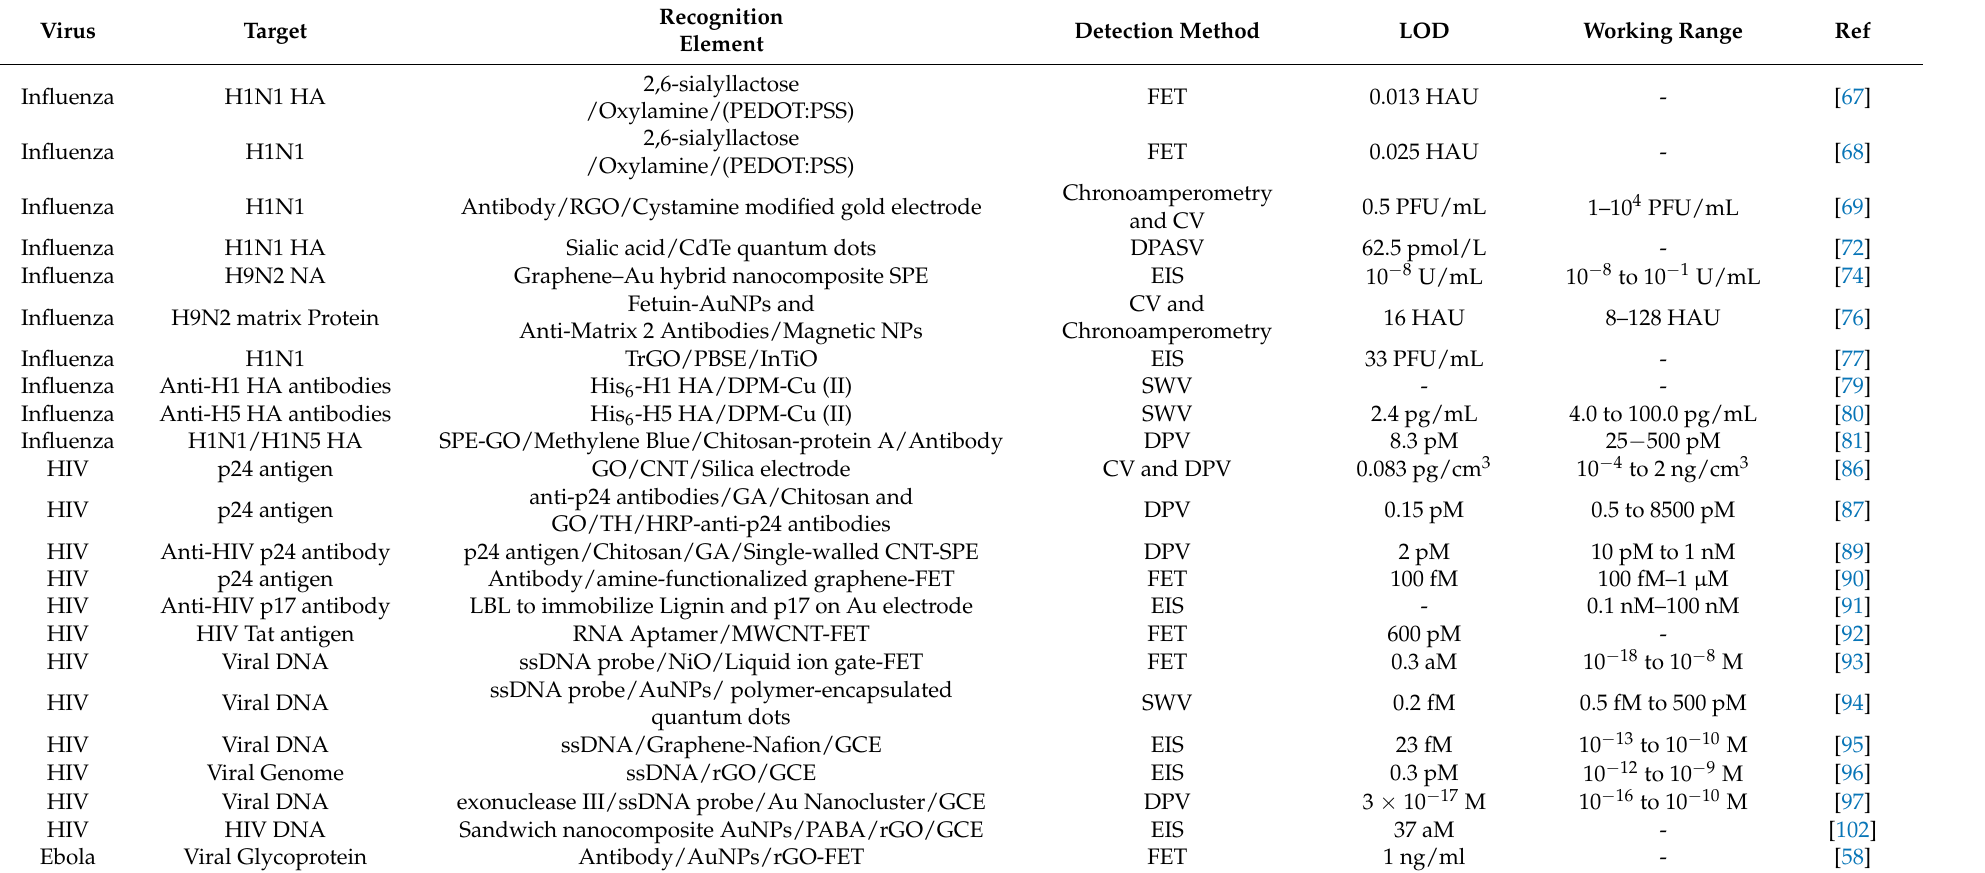
Table 1. Summary of performance characteristics of developed biosensors for Influenza, HIV, Ebola, Zika, and